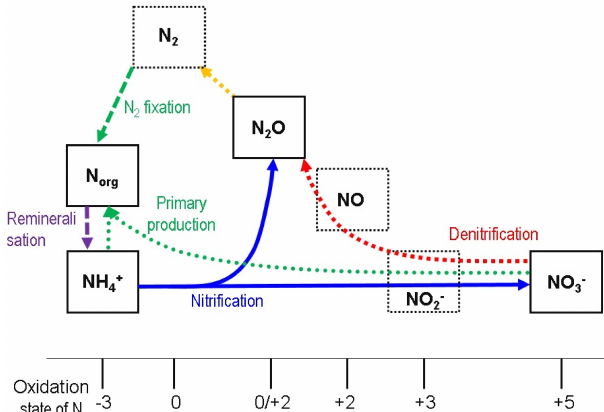
Figure 1. Primary biological pathways of the oceanic nitrogen N cycle represented in the model simulations, along with redox states of N. Nitrification occurs in the oxic ocean (blue arrow). Den- itrification yields net N 2 O production in hypoxic conditions (red arrow) and net N 2 O consumption in suboxic conditions (yellow ar- row). Only organic nitrogen (N org ), NH + resented as model state